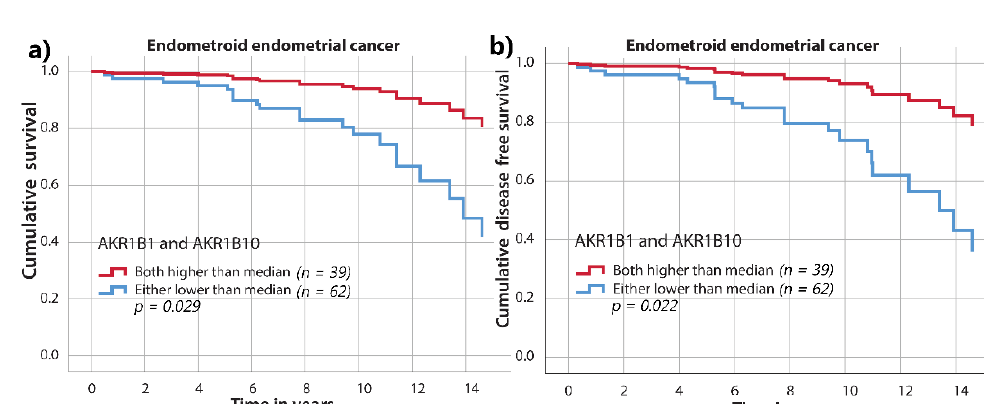
Figure 8. Overall survival and disease-free survival in relation to AKR1B1 and AKR1B10. One group includes cases with both AKR1B1 and AKR1B10 staining above the median values, and the other group includes cases with either AKR1B1 or AKR1B10 below the median values in endometrioid EC. ( a ) Overall survival ( p = 0.029) and ( b ) disease-free survival curves ( p = 0.022). Time on x axis represents time elapsed since initial diagnosis. AKR1B1: aldo-keto reductase family 1 member B1; AKR1B10: aldo-keto reductase family 1 member B10. Multivariant Cox analyses of independent prediction factors of overall and disease-free survival were performed (Table 3). For overall survival, the significant prediction factors, in descending order, were lymphovascular invasion ( p = 0.001), risk group (EC grade I–II vs. EC III or SC) ( p = 0.005), and AKR1B1 and AKR1B10 expression above the median values ( p = 0.036). For disease-free survival, the significant prediction factors were lymphovascular invasion ( p = 0.003), risk group (EC grade I–II vs. EC III or SC) ( p = 0.004), and AKR1B1 and AKR1B10 expression above the median values ( p =